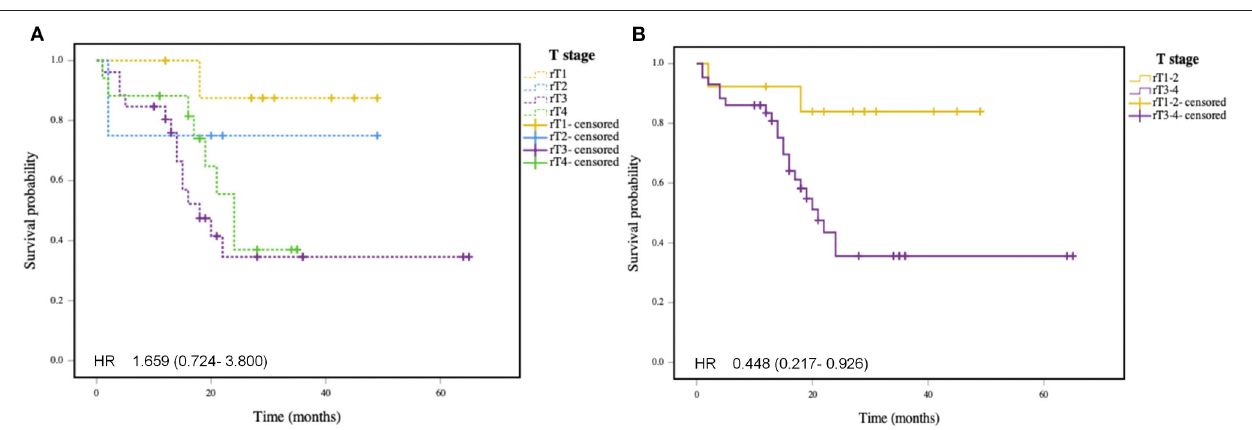
FIGURE 2 | (A) Kaplan-Meier curve of overall survival in patients with different rT stages. (B) Kaplan-Meier curve of overall survival in patients with early stage recurrent NPC and advance stage recurrent NPC ( P <